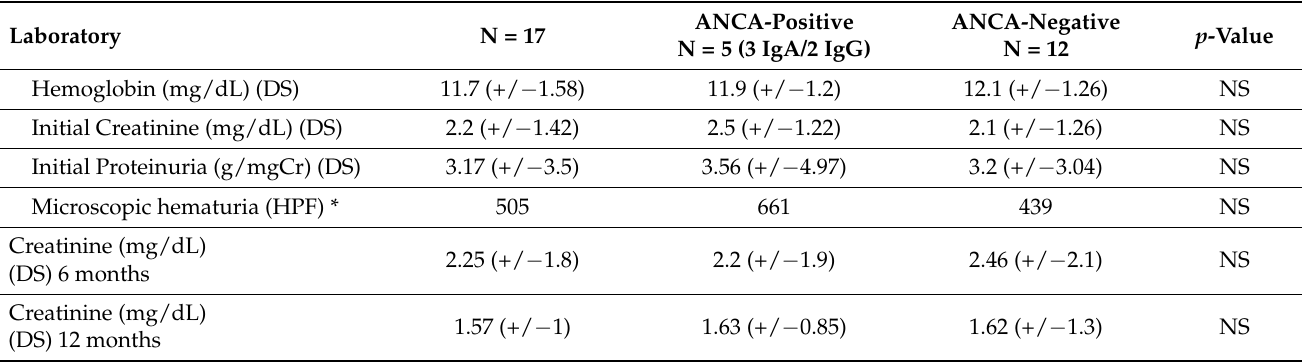
Table 2. Laboratory data of patients with crescentic IgA nephropathy according to the presence or absence of ANCAs.